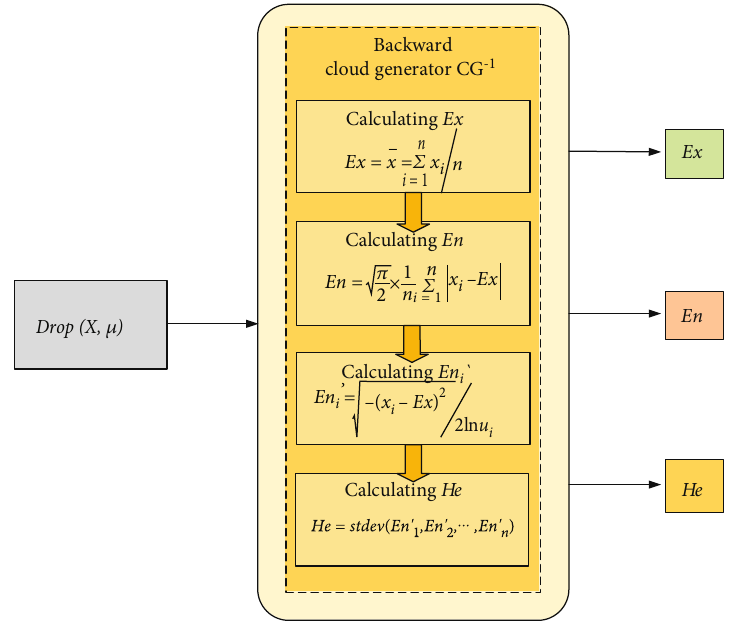
Figure 2: Forward cloud generator.